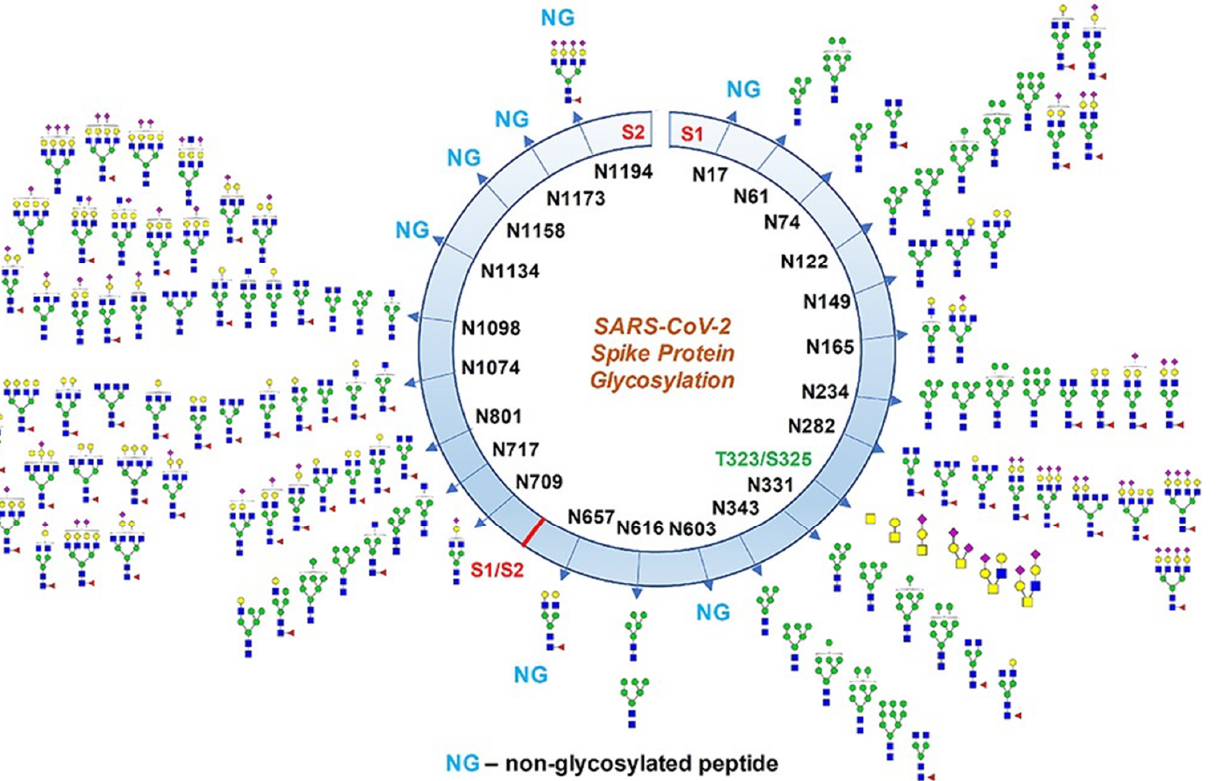
Figure 3. Glycosylation profile on coronavirus SARS-CoV-2 characterized by high-resolution LC- MS/MS. About 17 N-glycosylation sites were found occupied out of 22 potential sites along with two O-glycosylation sites bearing core-1 type O-glycans. Some N-glycosylation sites were partially glycosylated. Monosaccharide symbols follow the Symbol Nomenclature for Glycans (SNFG) system). This figure was reprinted and adapted permission from with the 2015 paper by Vari et al.